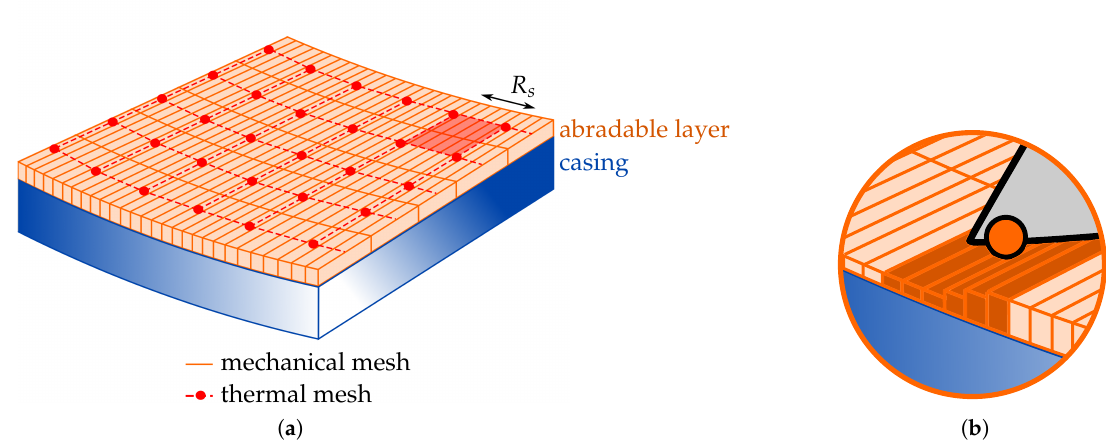
Figure 2. Abradable coating wear mechanism following blade/abradable coating contact event ( a ) and zoom on the abradable layer’s wear ( b ).